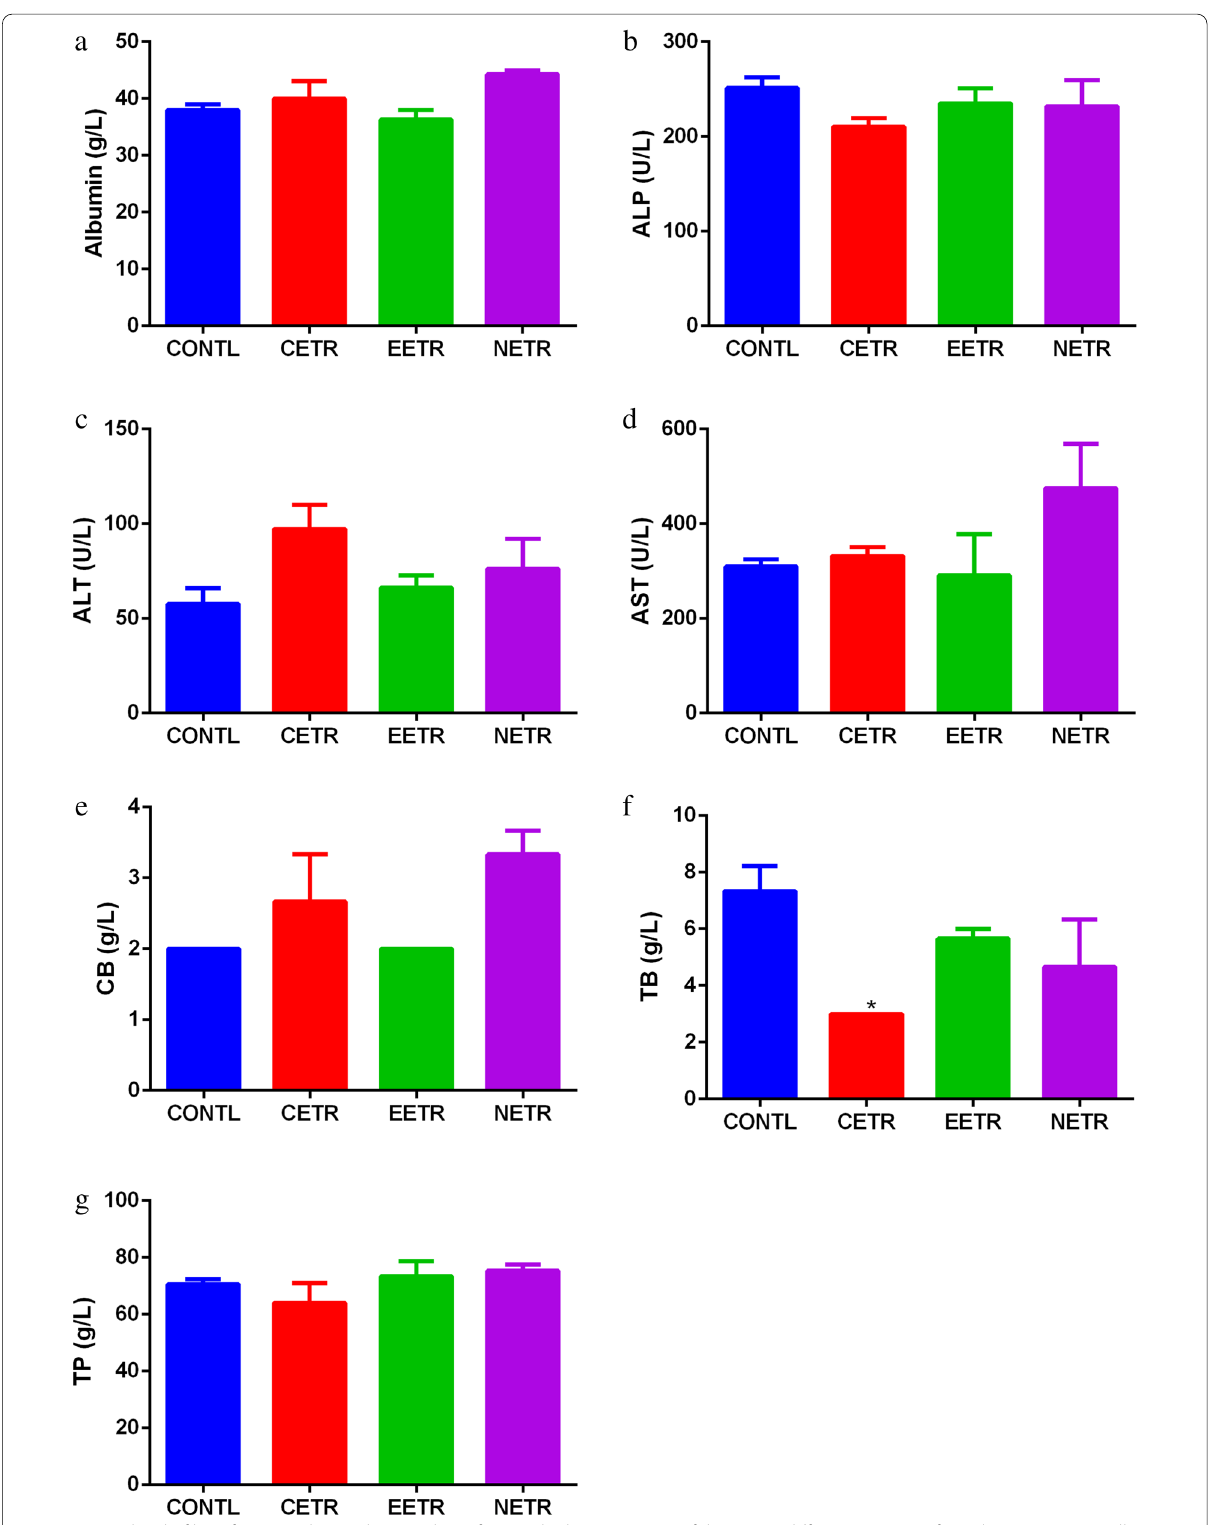
Fig. 3 Serum level of liver functions biomarkers 14 days after single dose exposure of the rats to different extracts of Bombax costatum . a Albumin, b ALP, c ALT, d AST, e CB, f TB and g